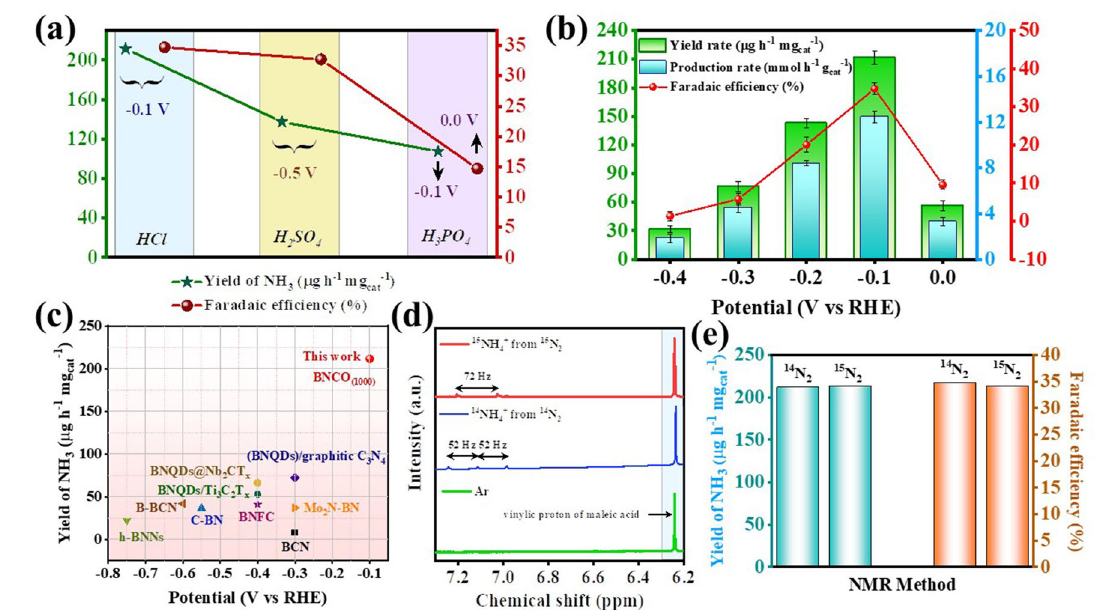
Fig. 4 a NRR performance of BNCO (1000) catalyst in different electrolyte conditions (0.1 M HCl, 0.1 M H 2 SO 4 and 0.1 M H 3 PO 4 ). b Com- parative plot showing yield and FE of NH 3 synthesis over the wide-ranging potential window for BNCO (1000) catalyst in 0.1 M HCl. c Yield of ammonia with respect to potential of our work, compared with all the BN or BNC class of catalysts reported so far for NRR. d Isotope labelling experiment displaying 1 H NMR spectra obtained after NRR in 0.1 M HCl with Ar, 14 N 2 and 15 N 2 feeding gases. e Comparison of ammonia yield and Faradaic efficiency, quantified by NMR method with 14 N 2 and 15 N 2 feeding gases with BNCO (1000)